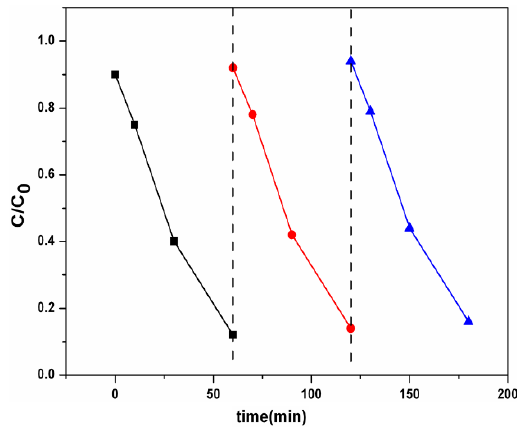
Figure 6. The repeated bleaching of RhB over recycled Ag Ag photocatalysts under visible